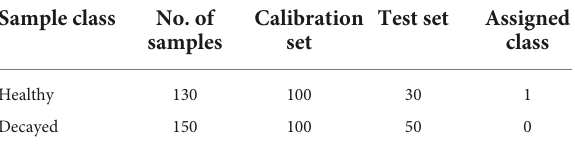
TABLE 2 Sample type and classification